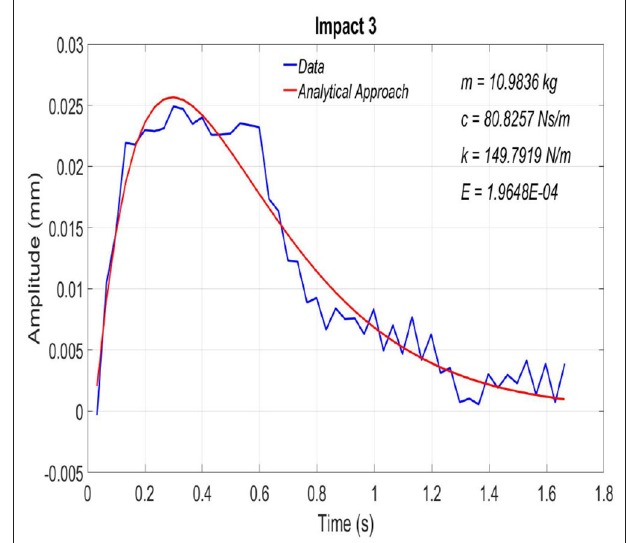
FIGURE 4 | Test 1, Optical characterization (blue) and Analytical results (red).